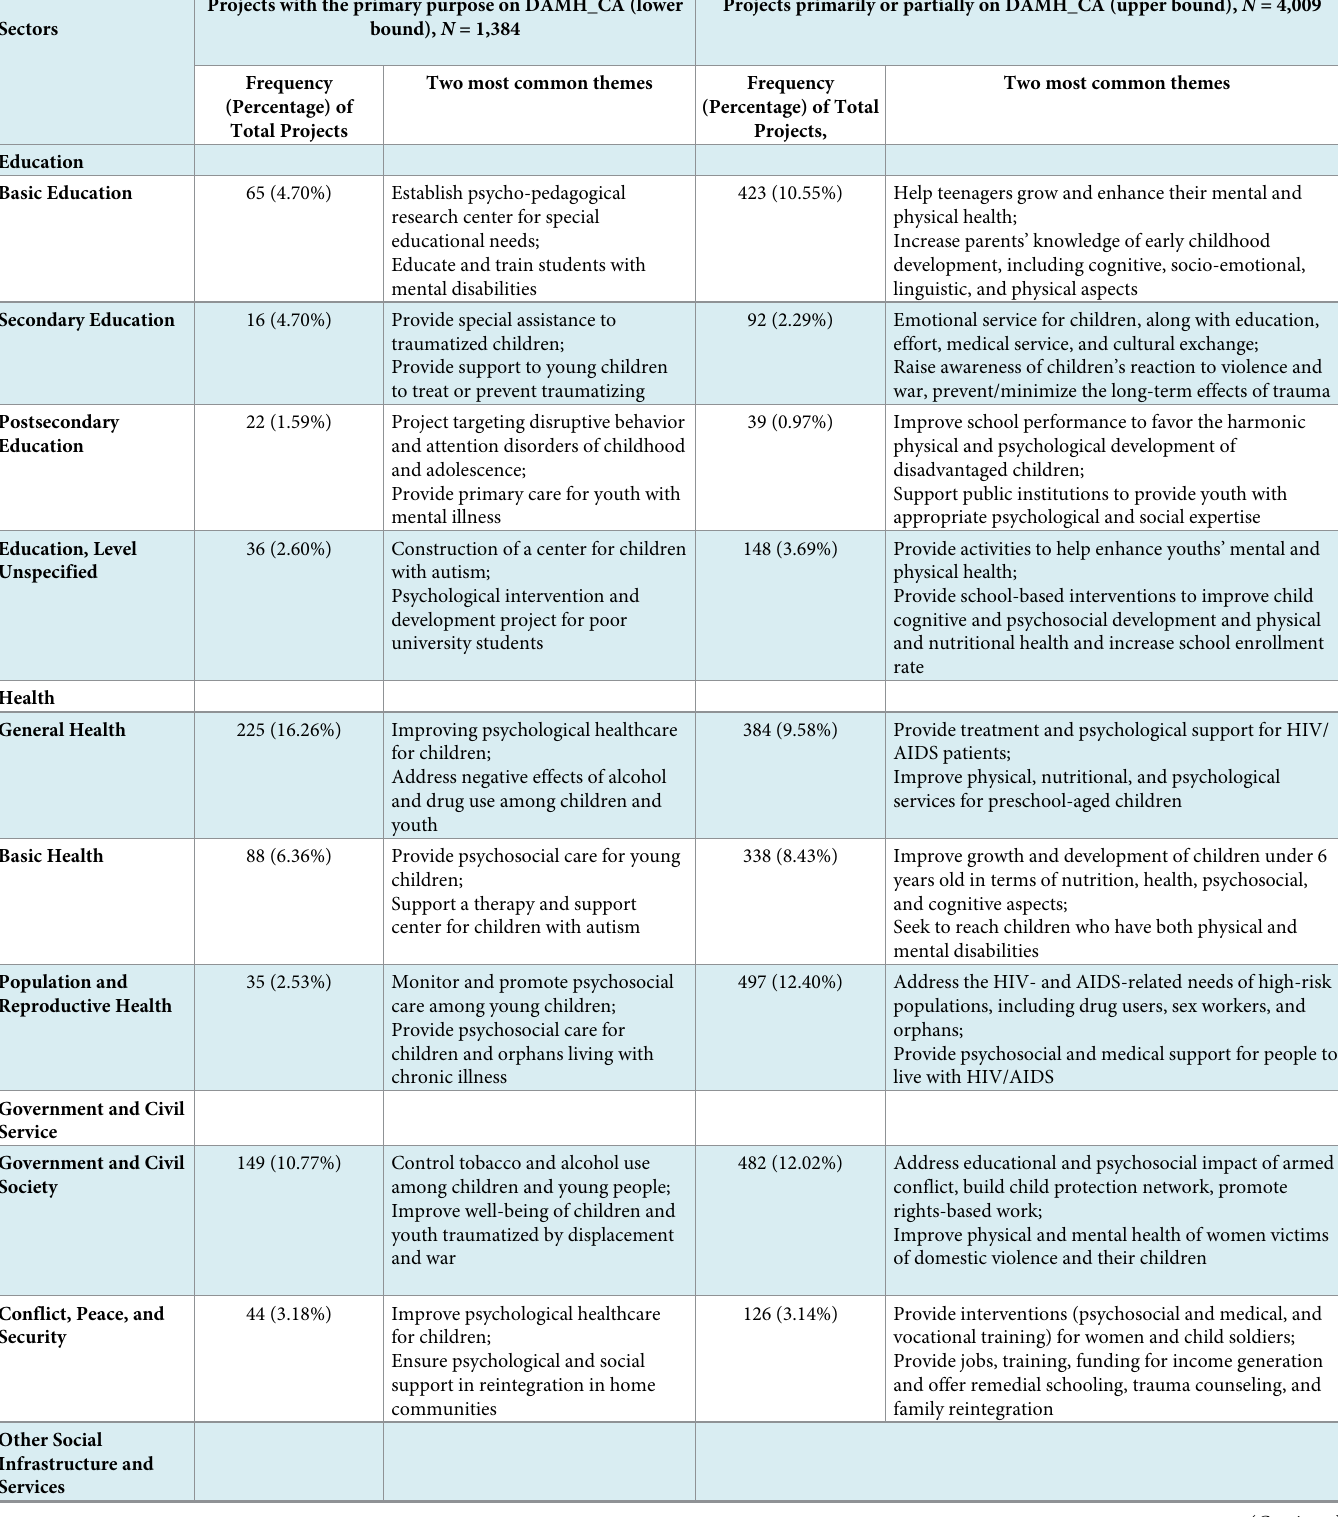
Table 1. Sectors for identifying DAMH_CA projects: Frequency and the two most common themes.